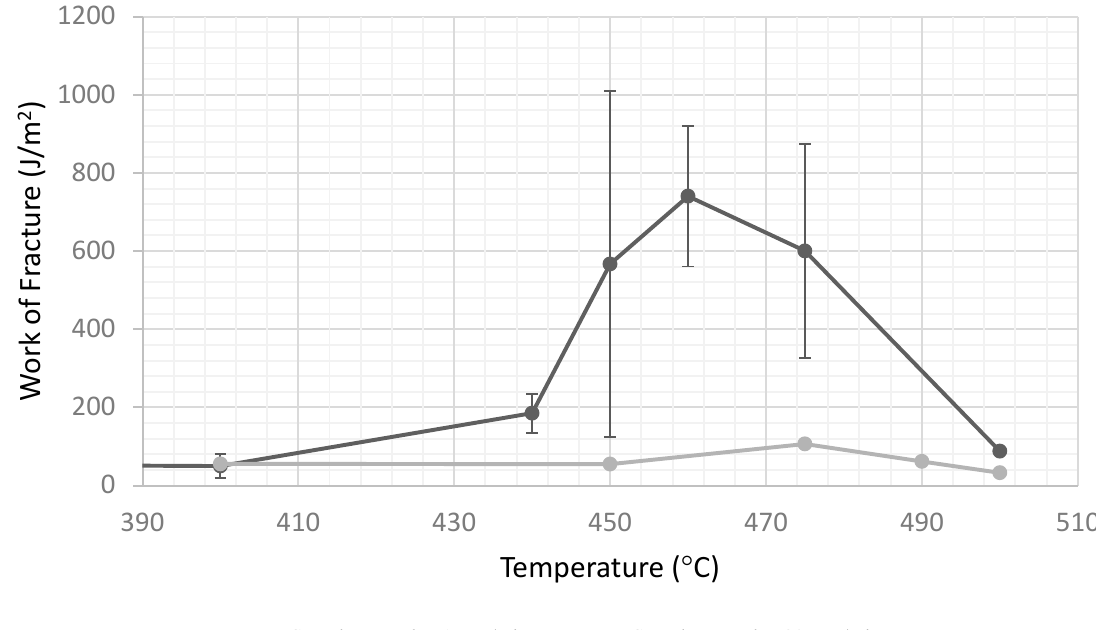
Figure 15. Critical strain energy release rate versus temperature for specimens tested at two different crosshead speeds.